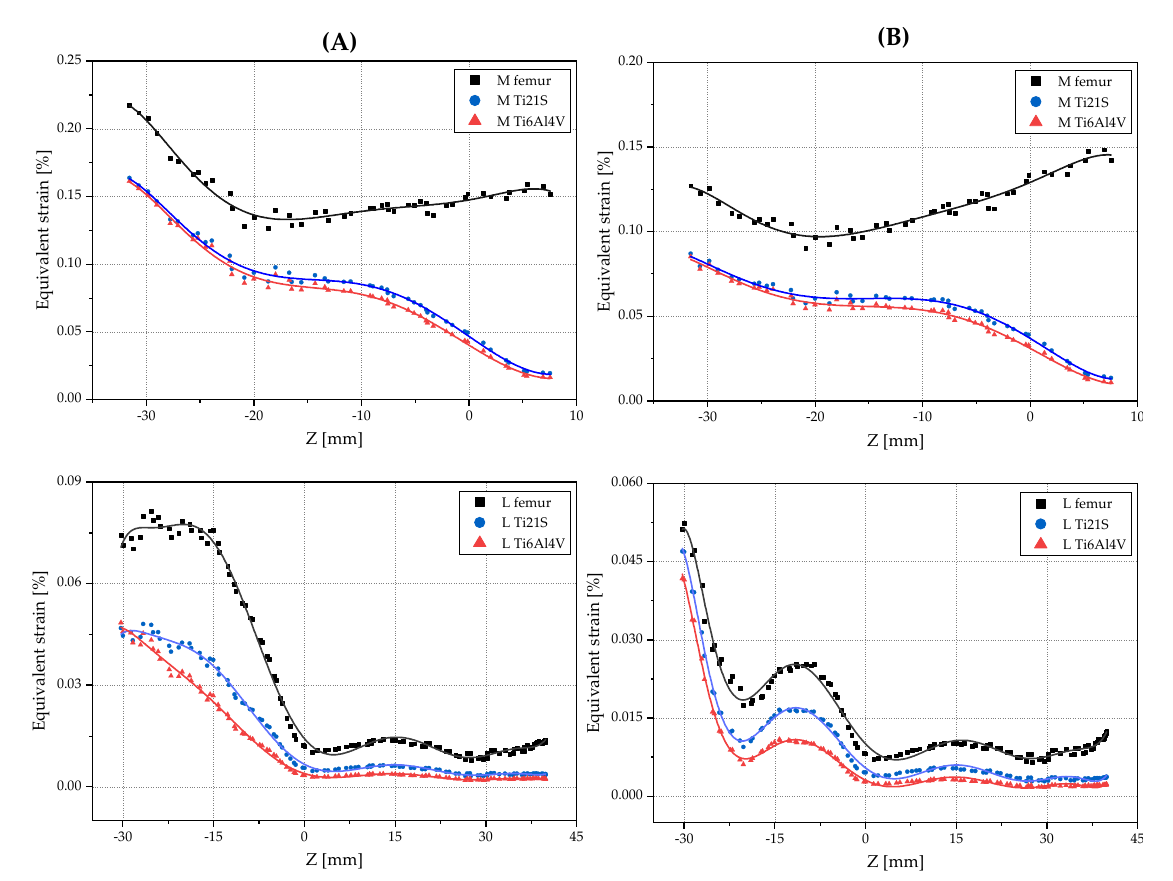
Figure 16. Scatter plots of the equivalent strain of GC1 in the medial and lateral sides under ( A ) ISO and ( B ) jogging loads.